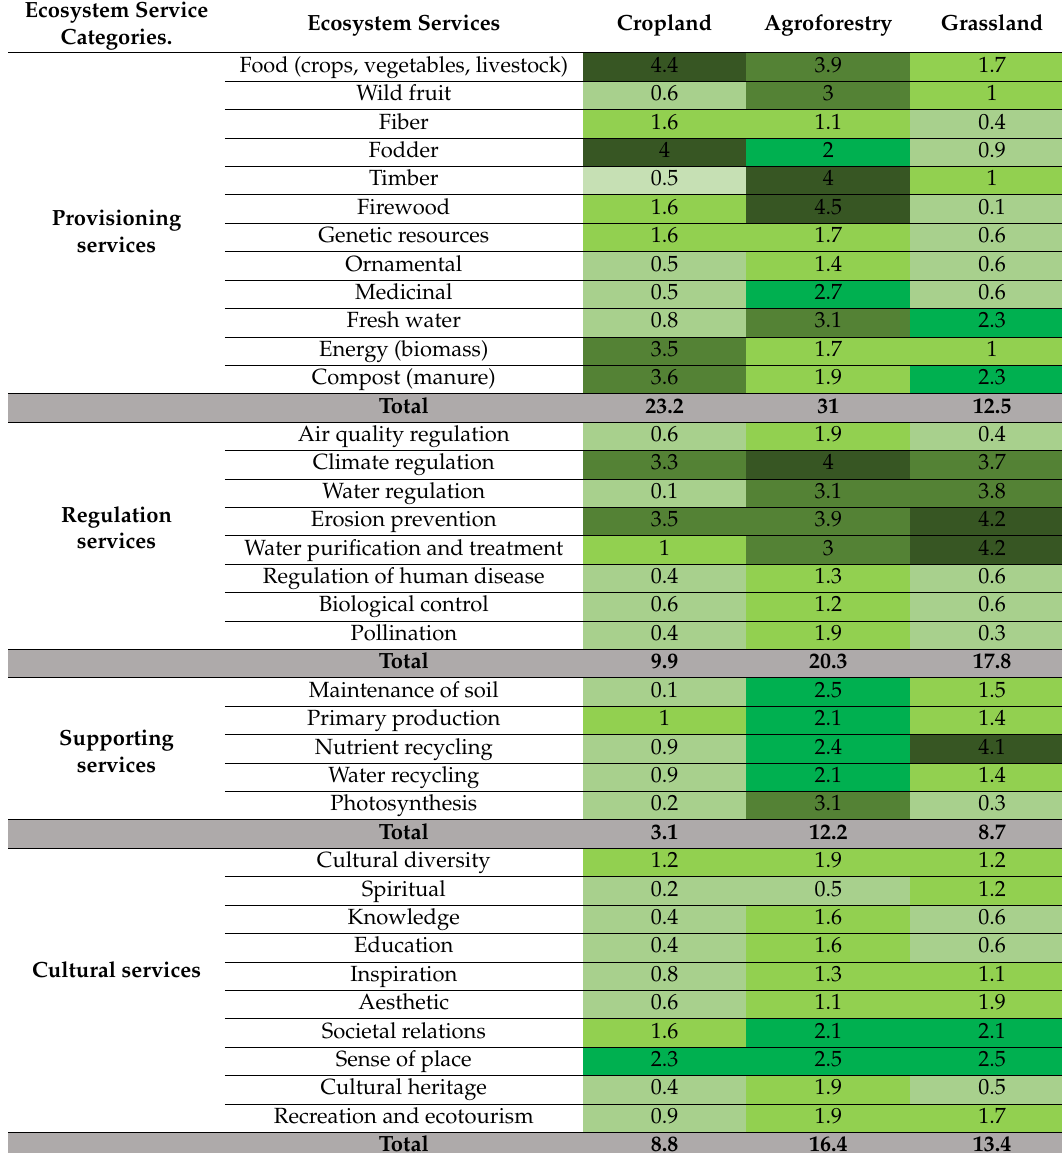
Table 2. Matrix for the assessment of the di ff erent land use types and their ES use. The assessment scale reaches from 0.1 to 0.99 = light green = very low usage, 1 to 1.99 = yellow green = low usage, 2 to 2.99 = green = medium usage, 3 to 3.99 = dark green = high usage and 4 to 5 = very dark green = very high